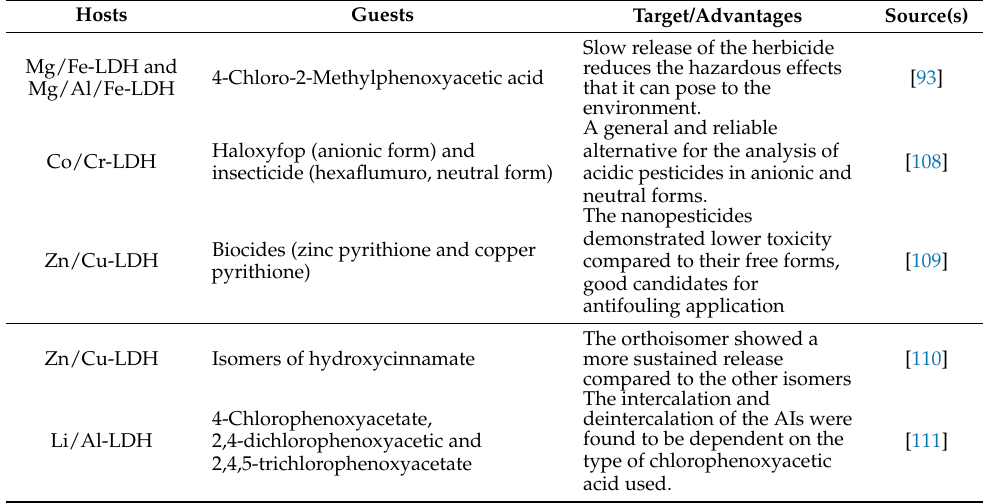
Table 7. Nanopesticides prepared using host–guest supramolecular chemistry based on various LDH hosts using various guests, AIs, for various targets and